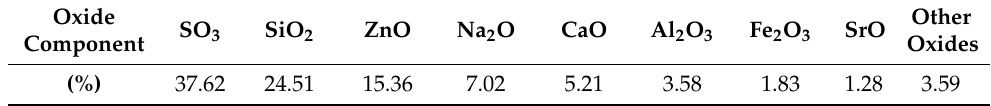
Table 1. Main oxide components of RRA.